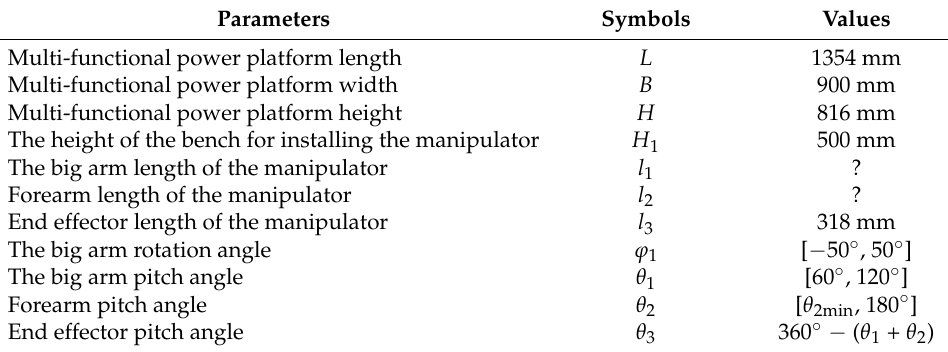
Figure 5. Reachable workspace of main links. Table 1. Pollen-picking manipulator parameters.